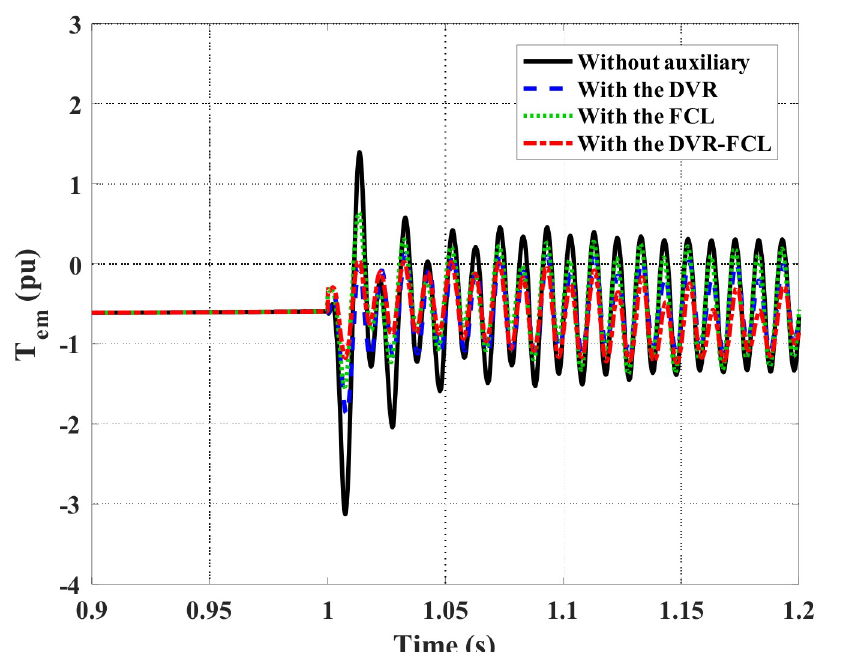
Fig 18. Electromagnetic torque of the DFIG subject to the asymmetrical fault.